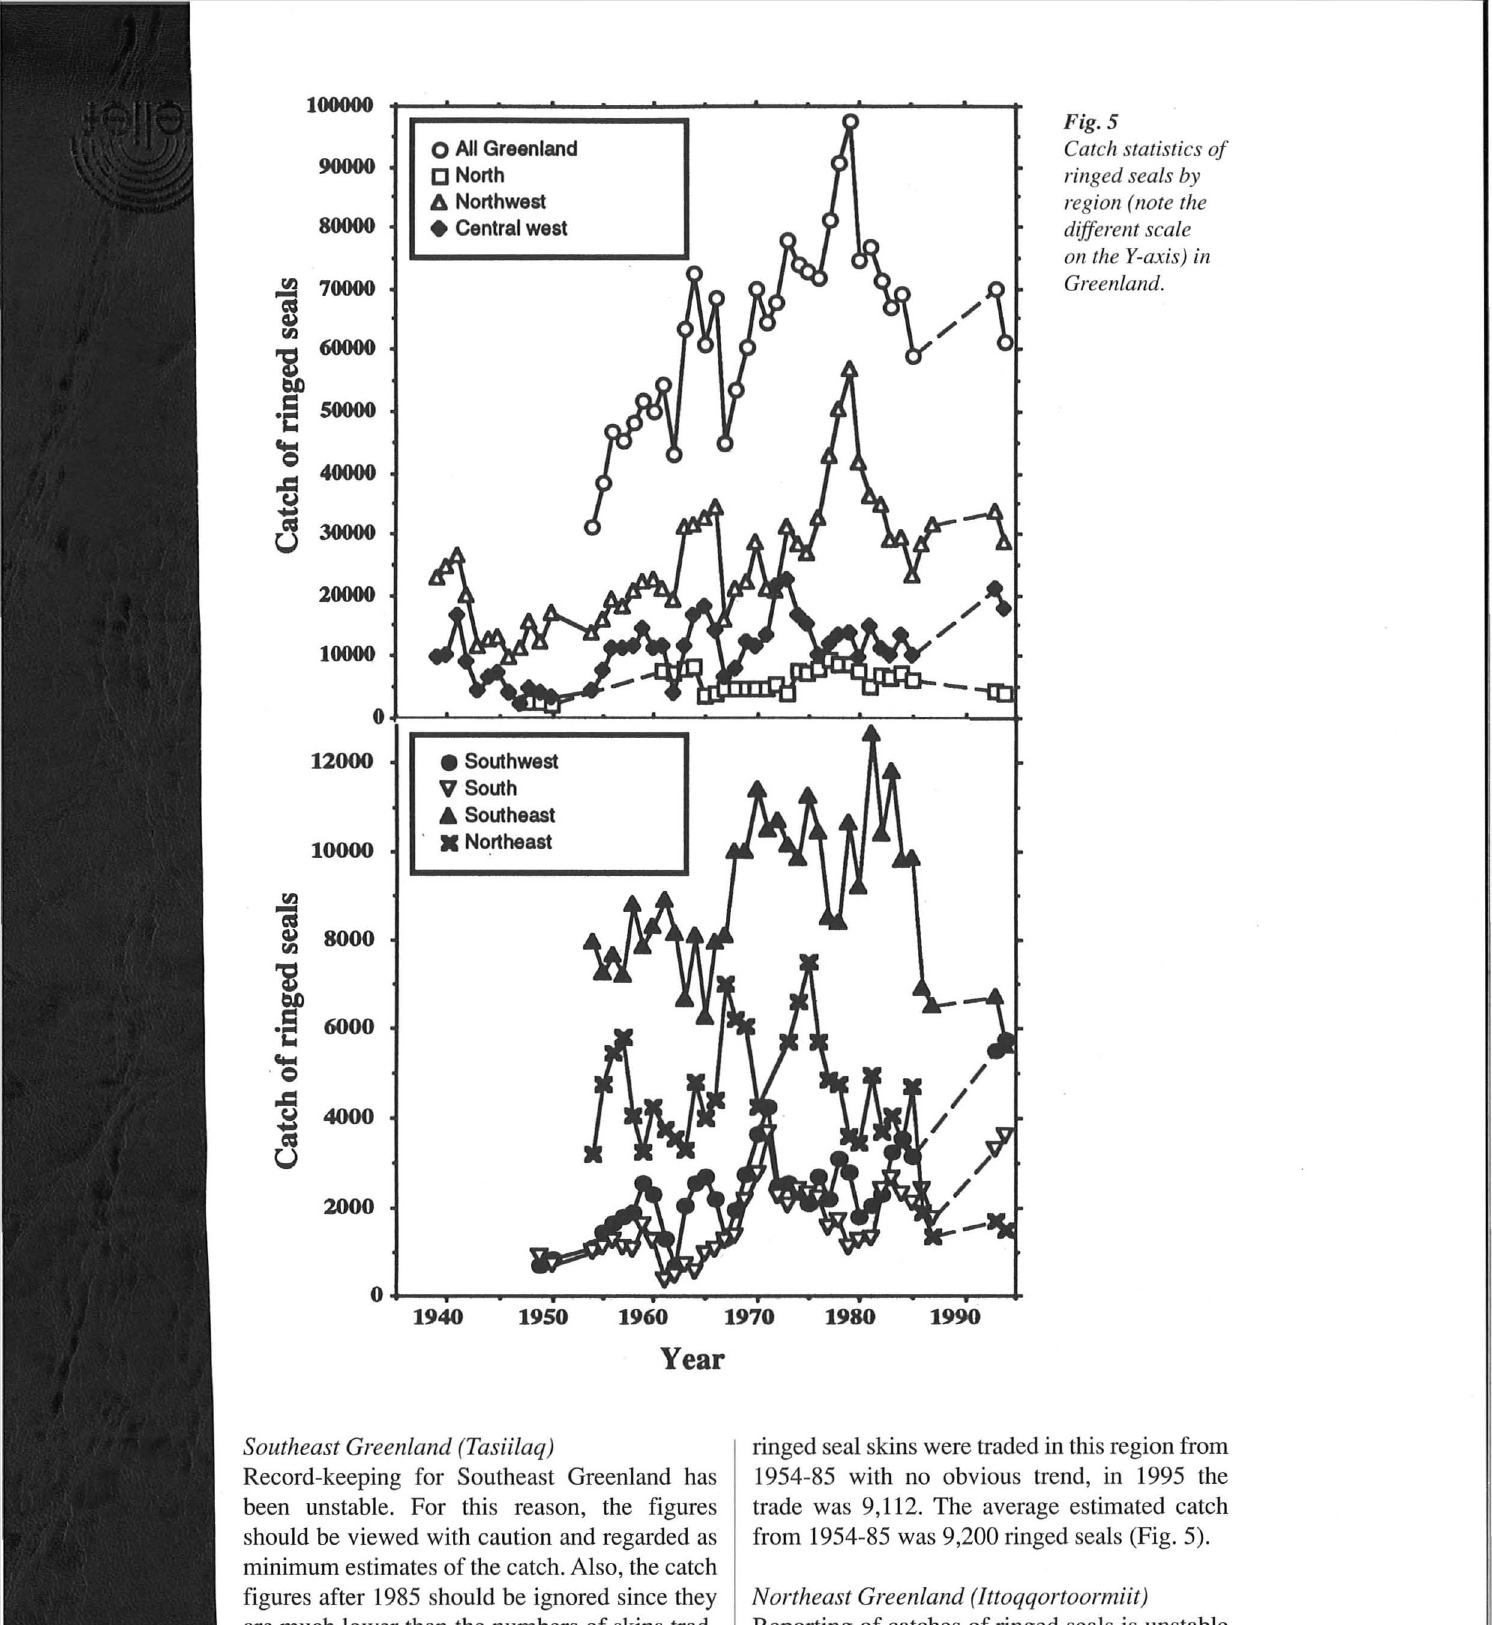
Fig. 5 Catch statistics of ringed seals by region (note the different scale on the Y-axis) in